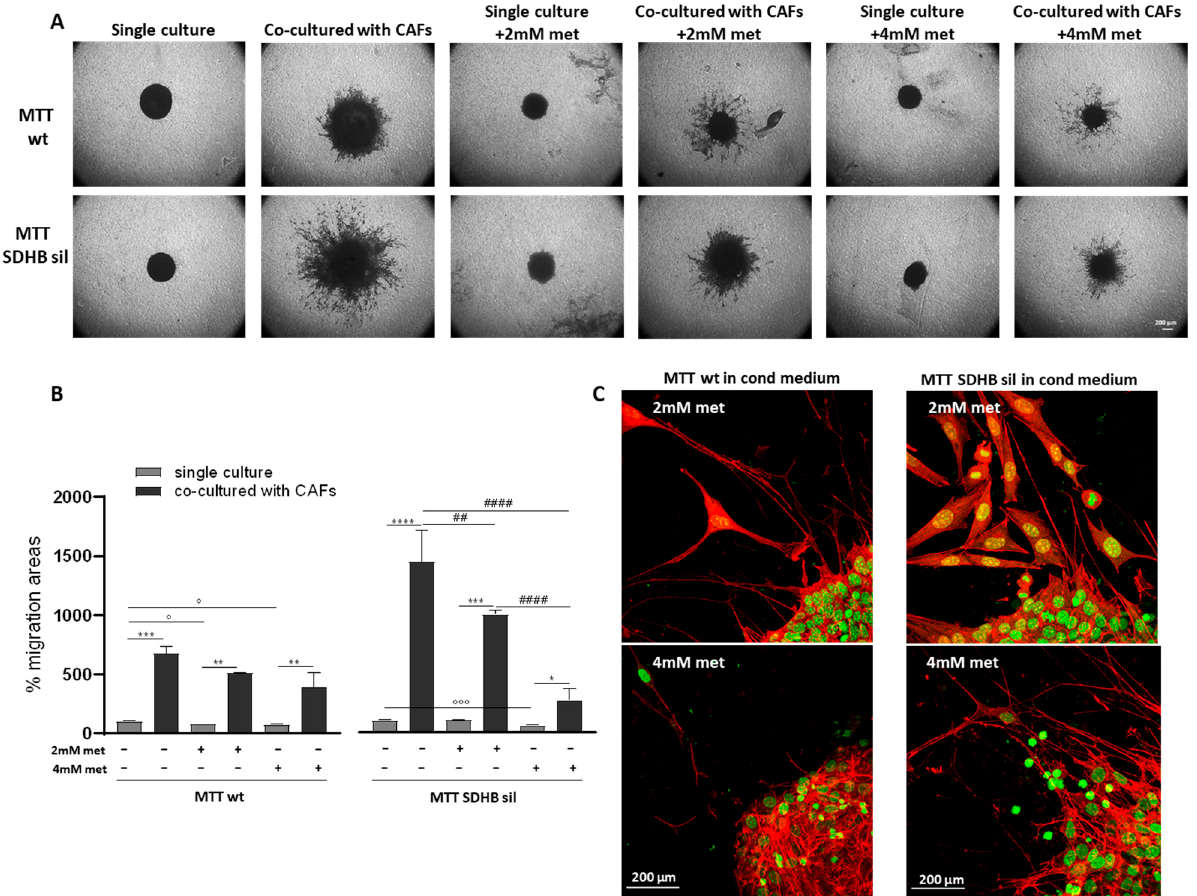
Figure 5. Effects of metformin on microenvironment-induced tumour spheroid migration. ( A ) Rep- resentative images of MTT wt and MTT SDHB sil spheroids, laid on 0.3% matrigel in transwell inserts, co-cultured or not with CAFs, and treated or not with 2 mM or 4 mM of metformin, acquired at low magnification (5×). Migration was observed after five days. In single culture, spheroid migrating cells were barely detectable. When spheroids were co-cultured with CAFs, plated in the lower compartment, a clear detachment of cells that invaded the surrounding space was observed. Spheroids in single cultures treated with 2 mM or 4 mM of metformin remained smaller compared with not treated spheroids, and in co-cultures, spheroid cell migration was only partially affected by metformin. Indeed, the core of the spheroid remained small, but migratory processes were still visible. ( B ) Bar graph quantifies the migration processes of MTT wt (left panel) and MTT SDHB sil (right panel) in single culture (light grey bars) on in co-culture with CAFs (dark grey bars) treated or not with 2 mM or 4 mM of metformin. Histograms represent the media of three independent experiments ± SD. Asterisks, hashtags, and circles indicate significance (Asterisks indicate the sta- tistic of values between treated and untreated spheroids, * p < 0.05, ** p < 0.01, *** p < 0.001, **** p < 0.0001. Hashtags indicate the statistic of values among the different treated spheroid populations, ## p < 0.01, #### p < 0.0001. Circles indicate the statistic of values among treated and untreated single cultured spheroids, ° p < 0.05, °°° p < 0.001) by one-way ANOVA with Tukey’s multiple comparisons post hoc test. ( C ) Representative images of tumour spheroid migration acquired by confocal micros- copy at high magnification (63×). Spheroids, grown in CAFs conditioned medium and 2 mM or 4 mM of metformin, were labelled with phalloidin (Thermo Fisher Scientific) to visualize actin fila- ments (in red), and with SYTOX™ Green Nucleic Acid Stain (Invitrogen) for nuclei staining (in green). Confocal images were acquired with a Leica SP2-AOBS, processed using Fiji software, and shown as maximum intensity projection along the z -axis. After five days, the elongation processes were still present in both MTT wt and MTT SDHB sil spheroids.